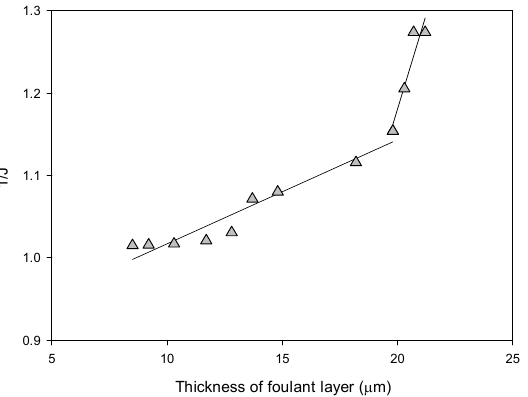
Figure 6. Correlation between the foulant layer thickness and the reciprocal of flux for continuous RO operation.